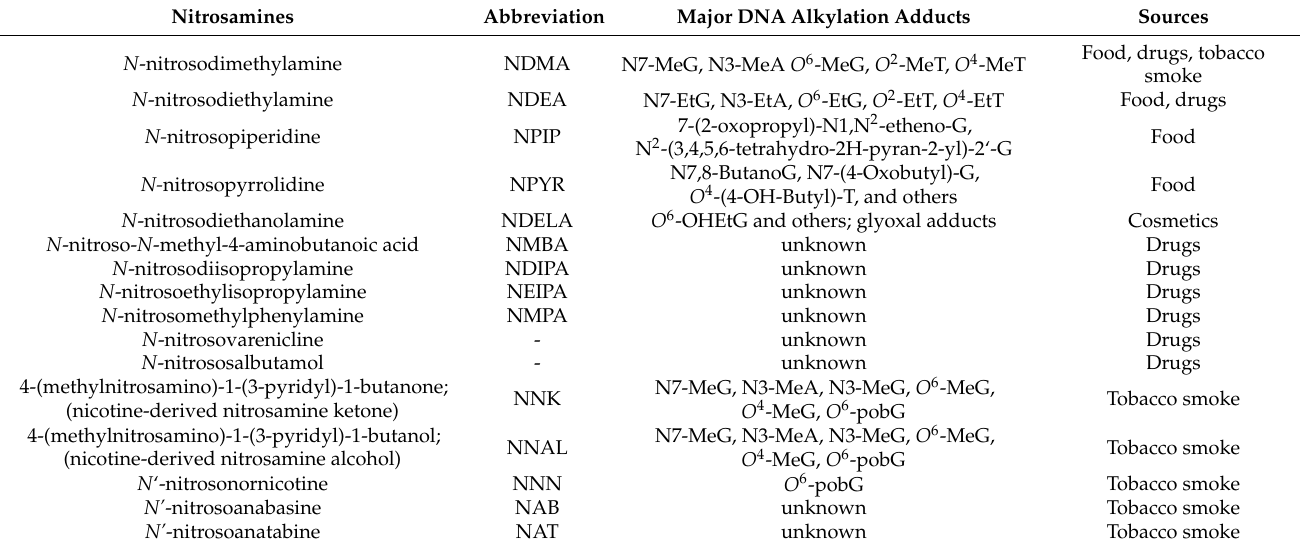
Table 1. Important nitrosamines, formed DNA alkylation adducts, and their